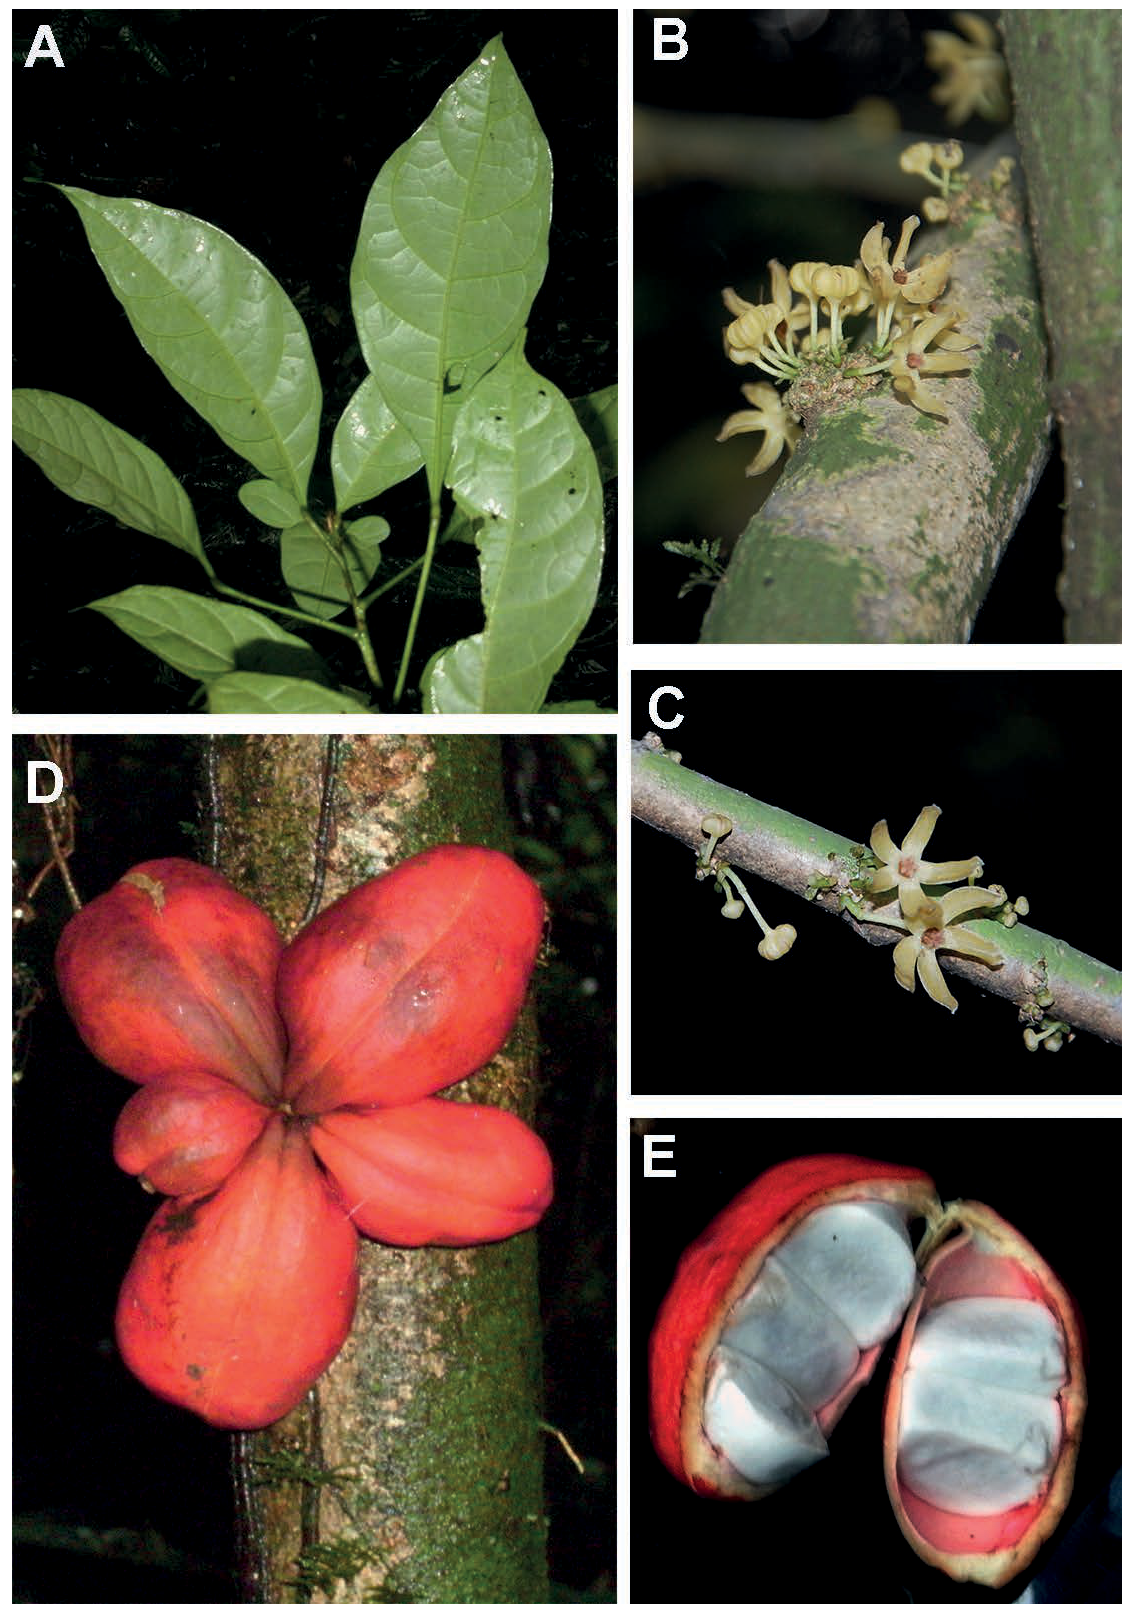
Figure 4 – Cola mamboana : A, leafy twig from below; B, dense fascicle; C, lax fascicle; D, mature fruit; E, opened fruitlet showing seeds. Photographs by D.